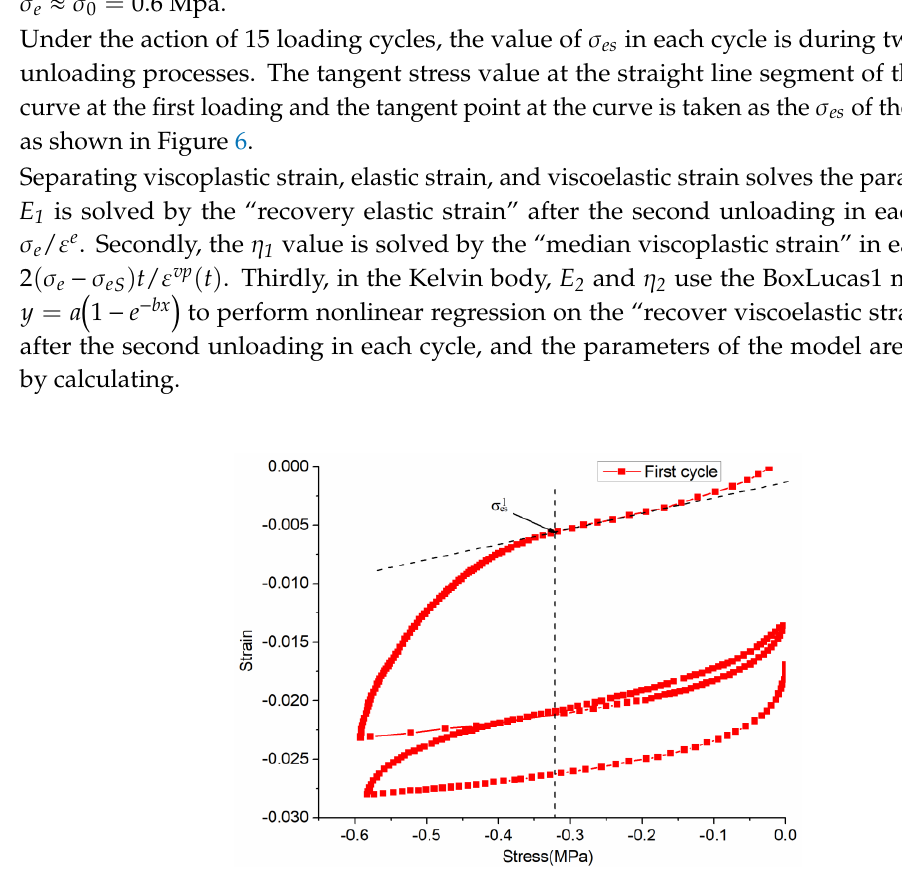
Figure 7. The first cycle strain – time curve of SAC-13.